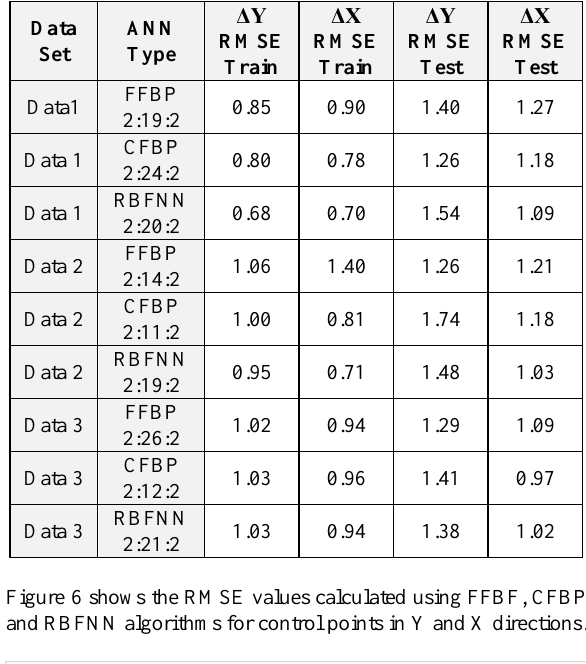
Table 1. Performance statistics calculated using FFBP, CFBP and RBFNN methods for reference and control points in Y and X directions (units: cm).